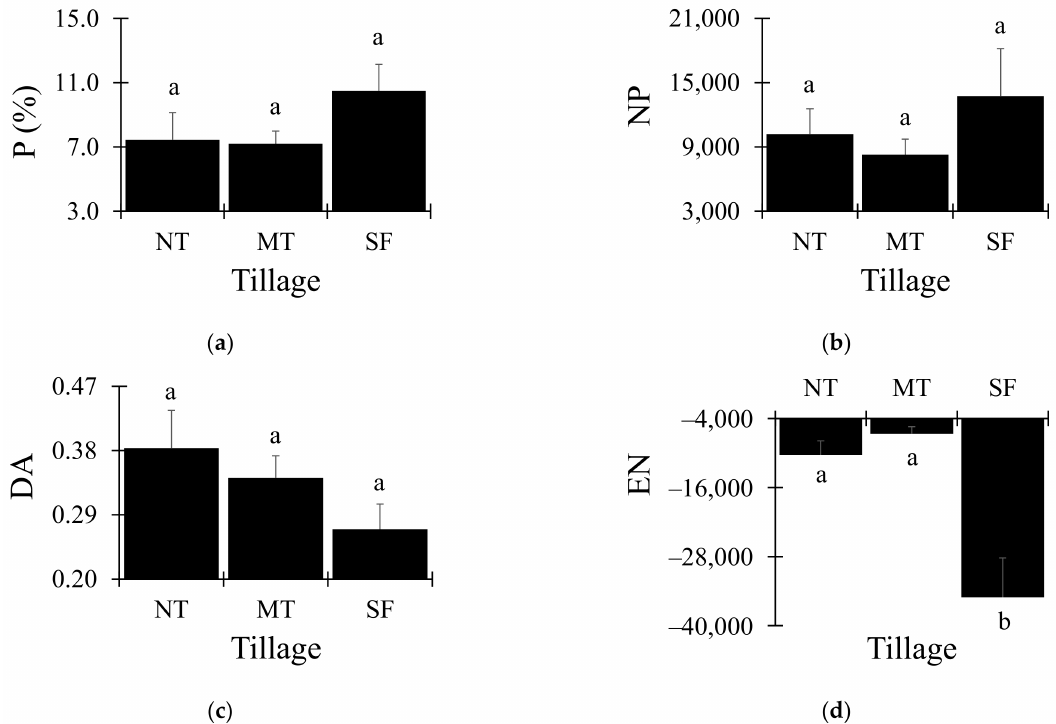
Figure 2. ( a ) Soil imaged porosity (P), ( b ) number of pores (NP), ( c ) degree of anisotropy (DA), and ( d ) Euler number (reflecting pore connectivity) for soil aggregates from no tillage (NT), minimum tillage (MT), and secondary forest (SF). Vertical bars represent the standard error ( n = 6). Different letters represent significant differences among management practices (Tukey’s HSD; p <